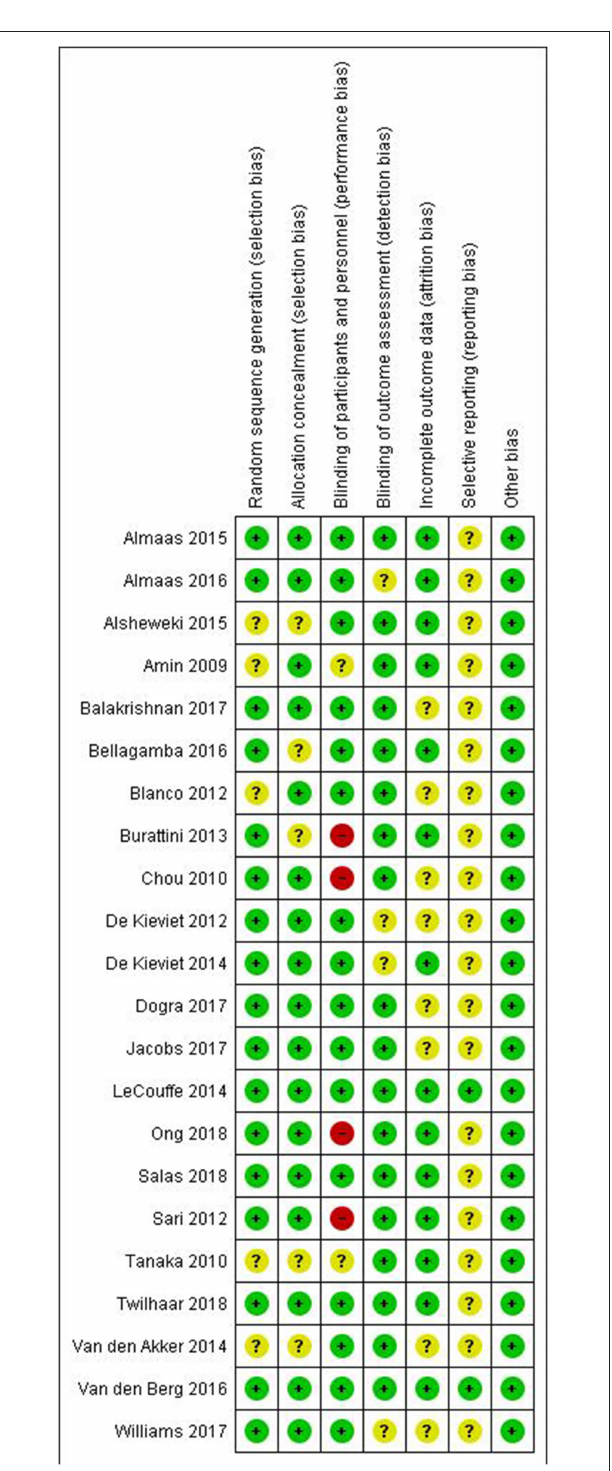
FIGURE 5 | Risk of bias of individual clinical studies.